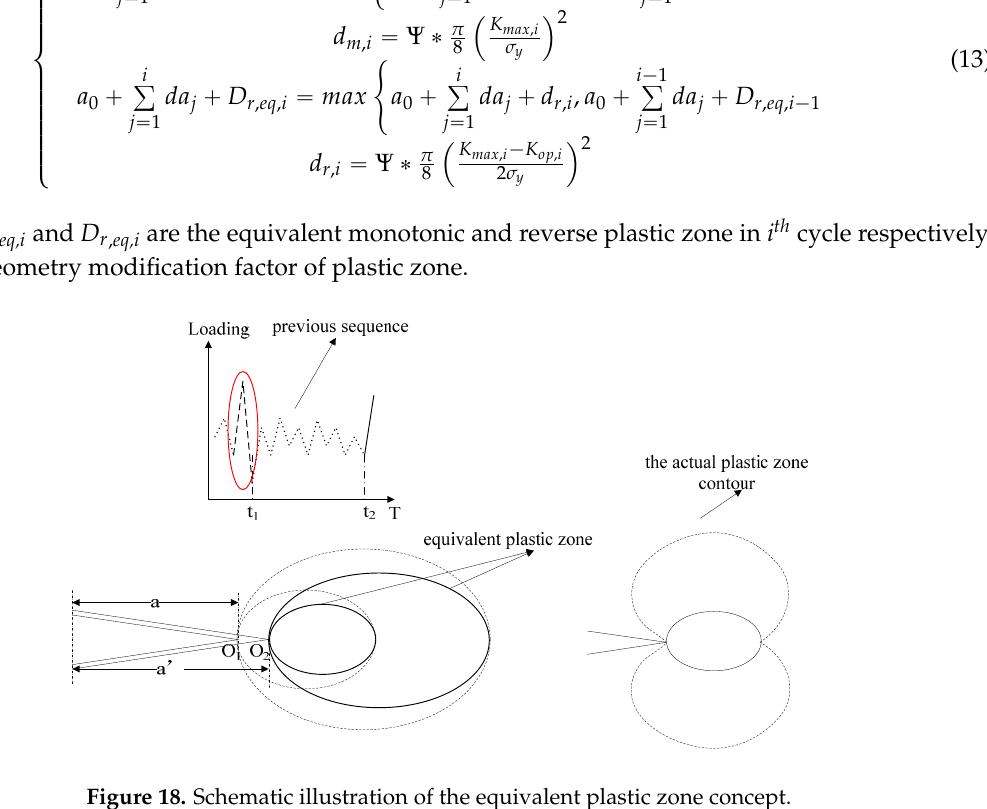
Figure 19. The calculation of the equivalent plastic zone.